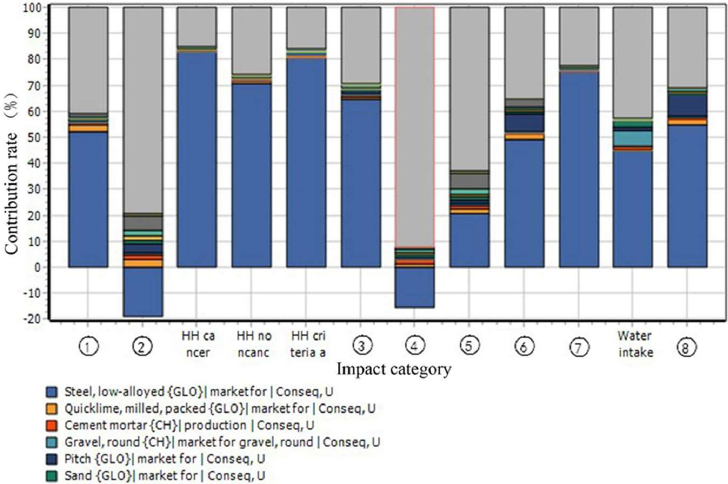
Figure 5. The characterization result of fast track transportation project in construction phase. Note: HH cancer, HH noncancer, HH criteria air pollutants, and Water intake are redundant Environmental impact categories which are currently used less frequently. This study does not take those four categories into account. The meanings of the ① ~ ⑧ are: ① Global warming, ② Acidification, ③ Eutrophication, ④ Ecotoxicity, ⑤ Smog, ⑥ Natural resource depletion, ⑦ Habitat alteration, ⑧ Ozone depletion.